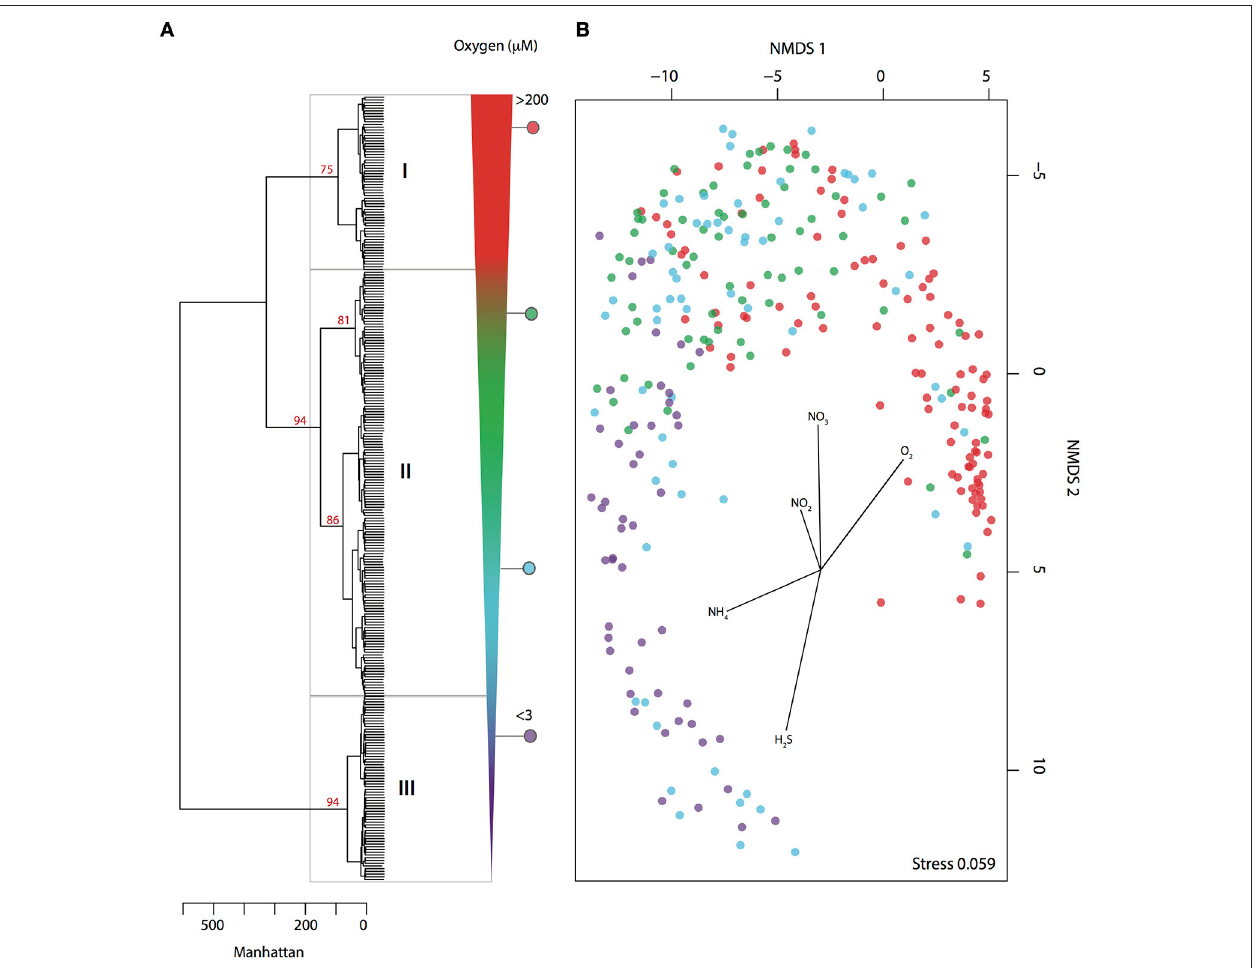
FIGURE 1 | Microbial community partitioning under changing levels of water column O 2 deficiency. (A) Hierarchical clustering of pyrotag data (May 2008–July 2010) based on Manhattan distance. Clusters are delimited by O 2 concentration range represented by number from I to III: oxic = I, dysoxic − suboxic = II and anoxic = III. Bootstrap values (1000 iterations) are shown in red. (B) NMDS depicts microbial community partitioning along redox gradient showing correlation with environmental parameters. Samples are depicted in color dots according to O 2